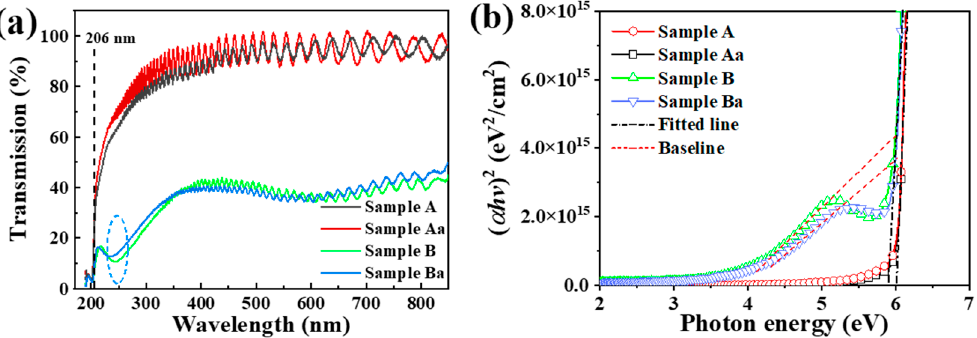
Figure 7. ( a ) Transmission spectra of AlN/sapphire before and after annealing. ( b ) Plots of ( α h υ ) 2 against photon energy (h υ ) for AlN films.